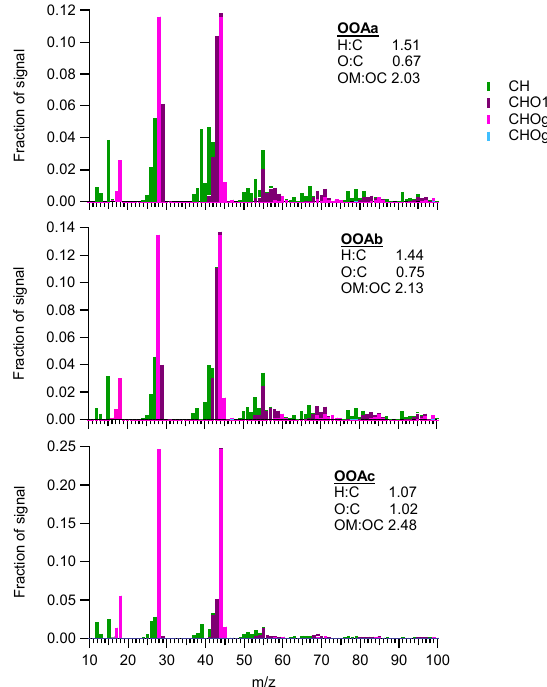
Figure 8. High-resolution mass spectra of the three factors extracted by PMF. Insets in each plot report the results of the elemental anal- ysis (from the I-A method).